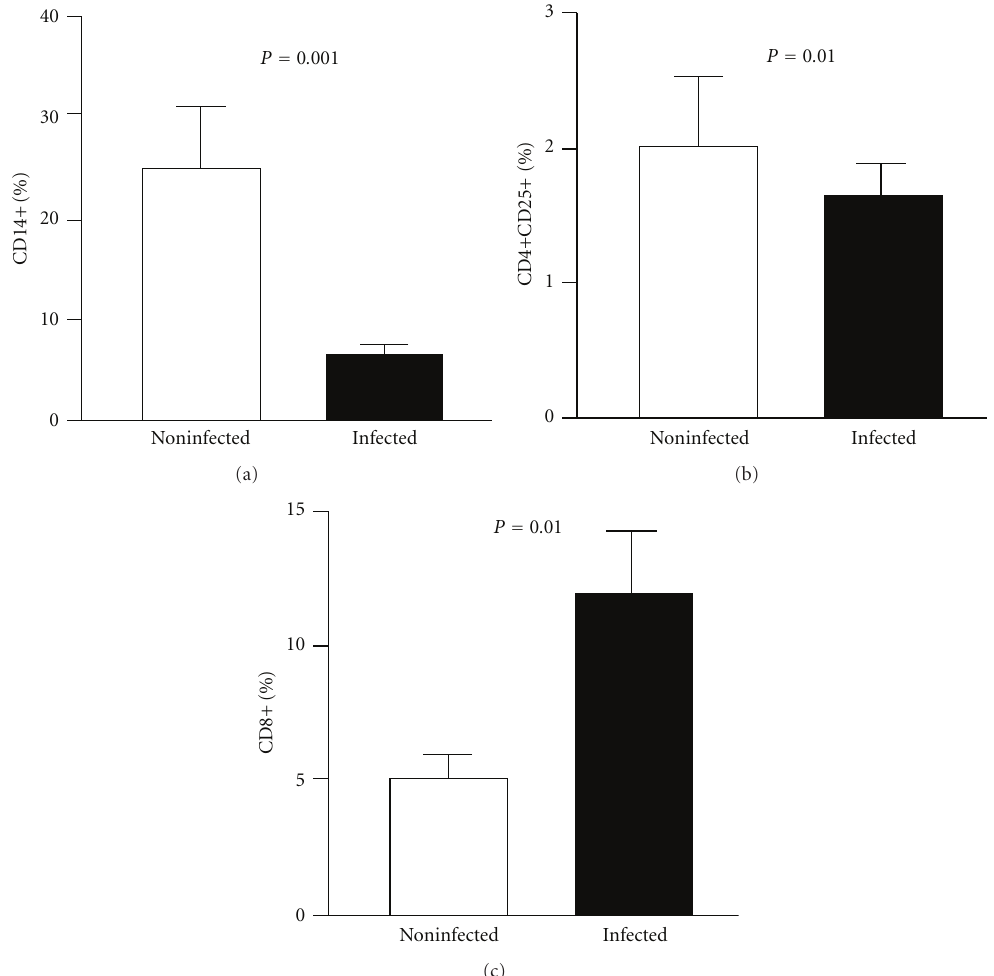
Figure 8: Aspects of the immune responses in mice infected or not with zoonotic Vaccinia virus . Peripheral blood mononuclear cells (PBMCs) from mice either infected with a zoonotic Vaccinia virus isolate or noninfected were cultured for 72 hours in the presence of UV-inactivated VACV. After incubation, cells were labeled with specific antibodies and analyzed by flow cytometry. (a) Percentage of total monocytes (CD14 + ); (b) percentage of CD4 + T lymphocytes expressing the CD25 surface activation marker; (c) percentage of CD8 + T lymphocytes. Bars represent the mean results from 10 animals. Error bars and P values are